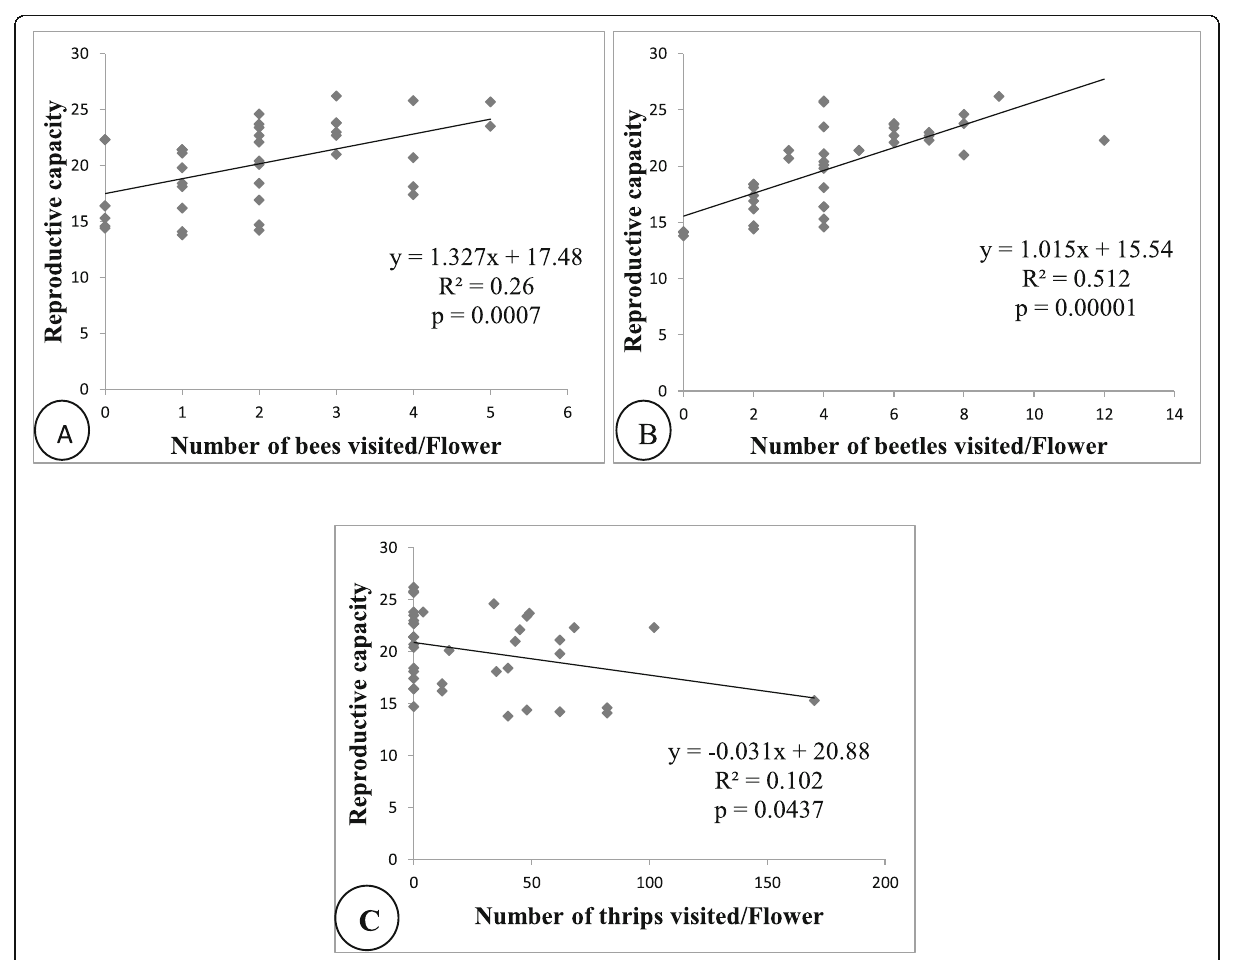
Fig. 2 Relationship between number of visits per flower and reproductive capacity in M . grandiflora for different visitors. a Bees (Hymenoptera), b beetles (Coleoptera) and c thrips